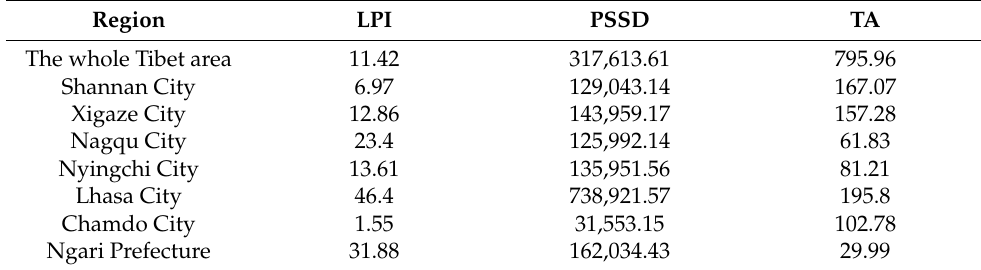
Table 3. LPI, PSSD, TA Index of residential patches in Tibet. Region LPI PSSD TA The whole Tibet area